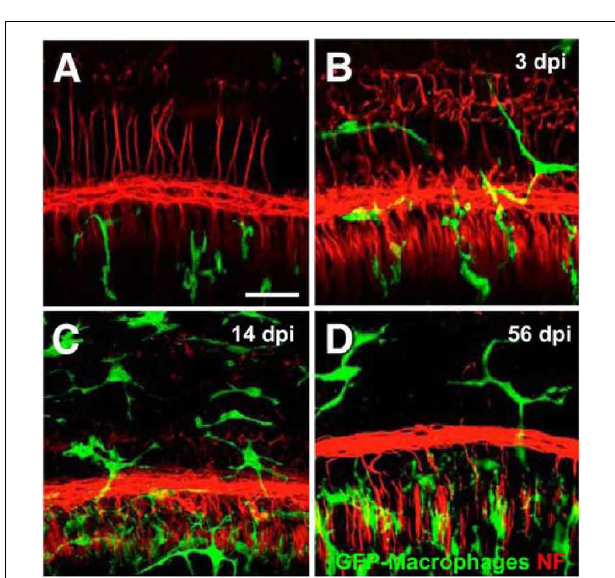
FIGURE 3 | Macrophages in the sensory epithelium of the cochlea after HC loss. Pou4f3 + / + (control) and Pou4f3 DTR / + mice were injected with a single dose of DT, and cochlear whole mounts were examined. (A) Controls, (B) 3 days after DT, (C) 14 days after DT, (D) 56 days after DT. GFP-expressing macrophages are in green, and neurons (neurofilaments) are in red. Compared with controls, the numbers of macrophages increased in the sensory epithelium of damaged (Pou4f3 DTR / + ) mice. Scale bar = 30 µ m [citing from Kaur et al.